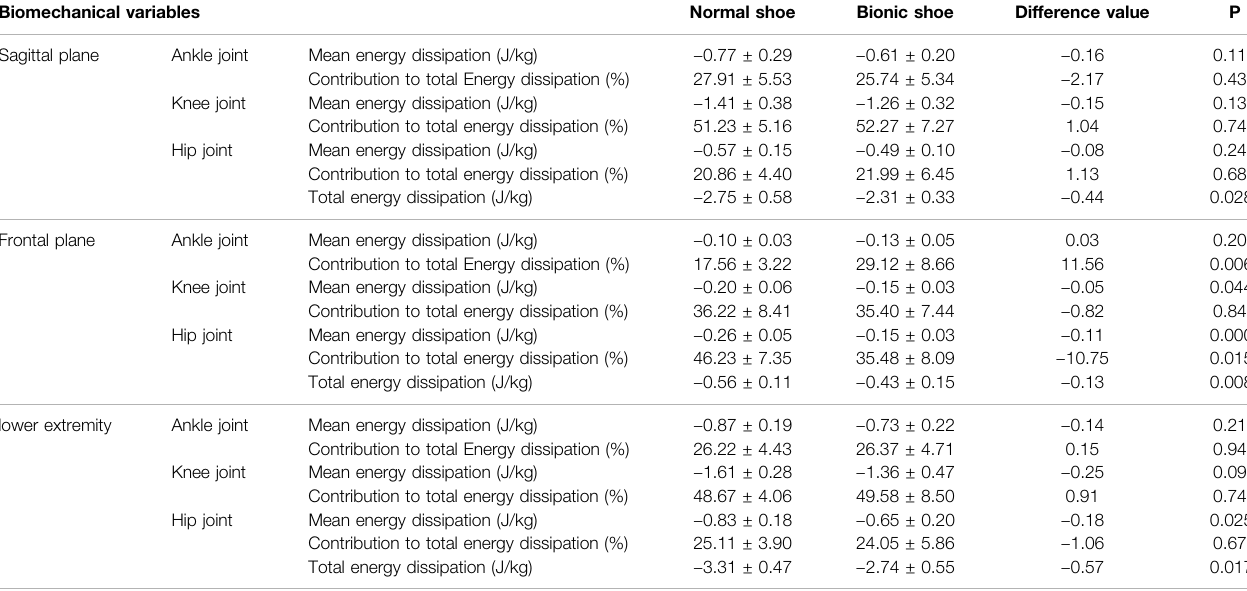
TABLE 3 | Comparison of mean energy dissipation and contribution to total energy dissipation in the sagittal plane, frontal plane, and lower extremity (means ± standard) between NS and BS during single-leg landing phase. Biomechanical variables Normal